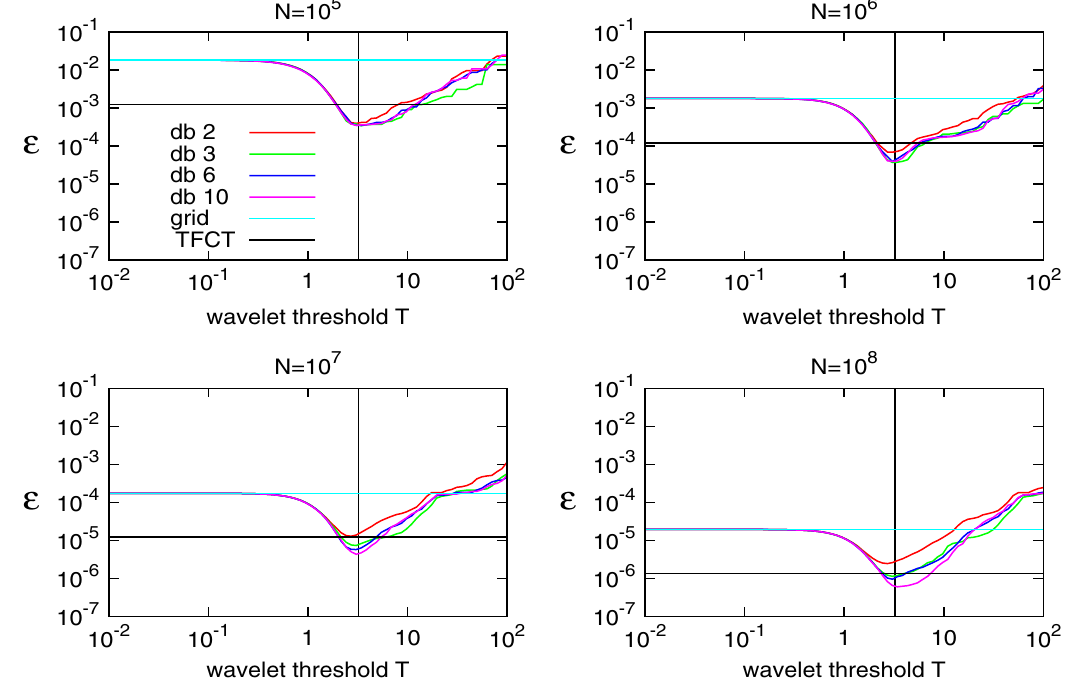
FIG. 4. Accuracy of the approximation (measured by the IMSE) as a function of the wavelet threshold T for the sinusoidally modulated flattop distribution used in Sec. IV. The resolution of the grid is fixed at 1024 (cid:3) 128 in ð z; x Þ space. Number of particles sampling the distribution is given in the title of each panel. The four curves correspond to the four different wavelets from Daubechies family: order 2 (red), order 3 (green), order 6 (blue), and order 10 (purple). The light blue horizontal line represents the accuracy of the grid deposition and black the cosine expansion. The vertical line is the analytical value of T ( k ¼ 2 ) is